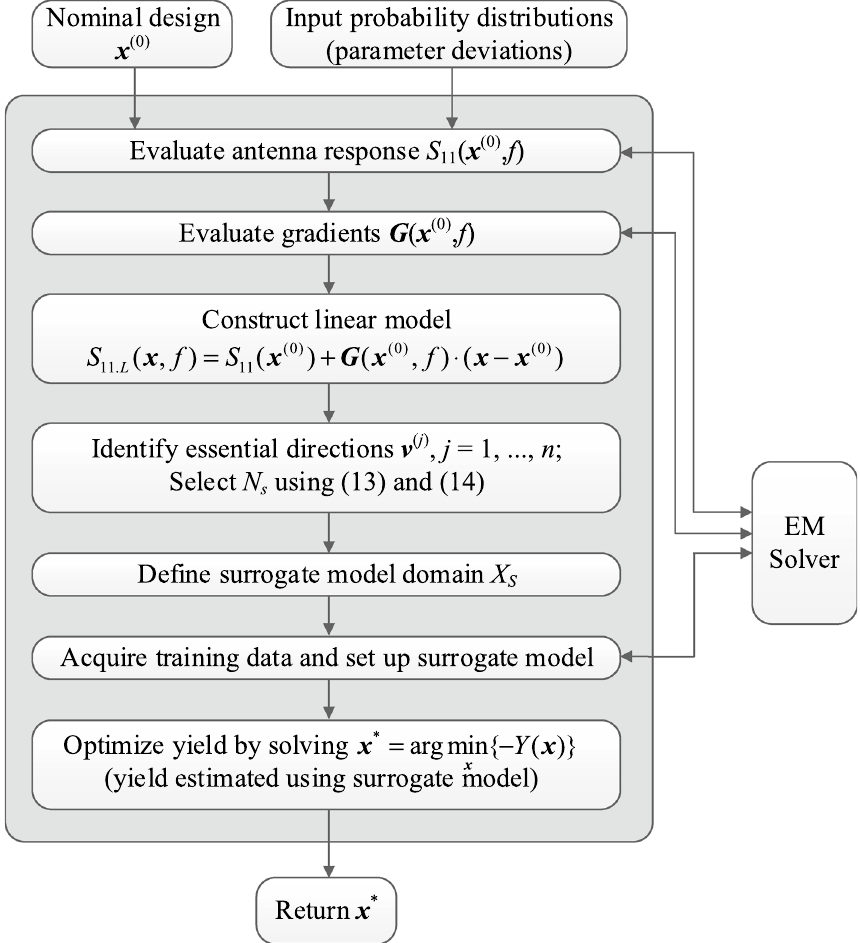
Figure 2. Flow diagram of the proposed surrogate-assisted robust design procedure involving essential